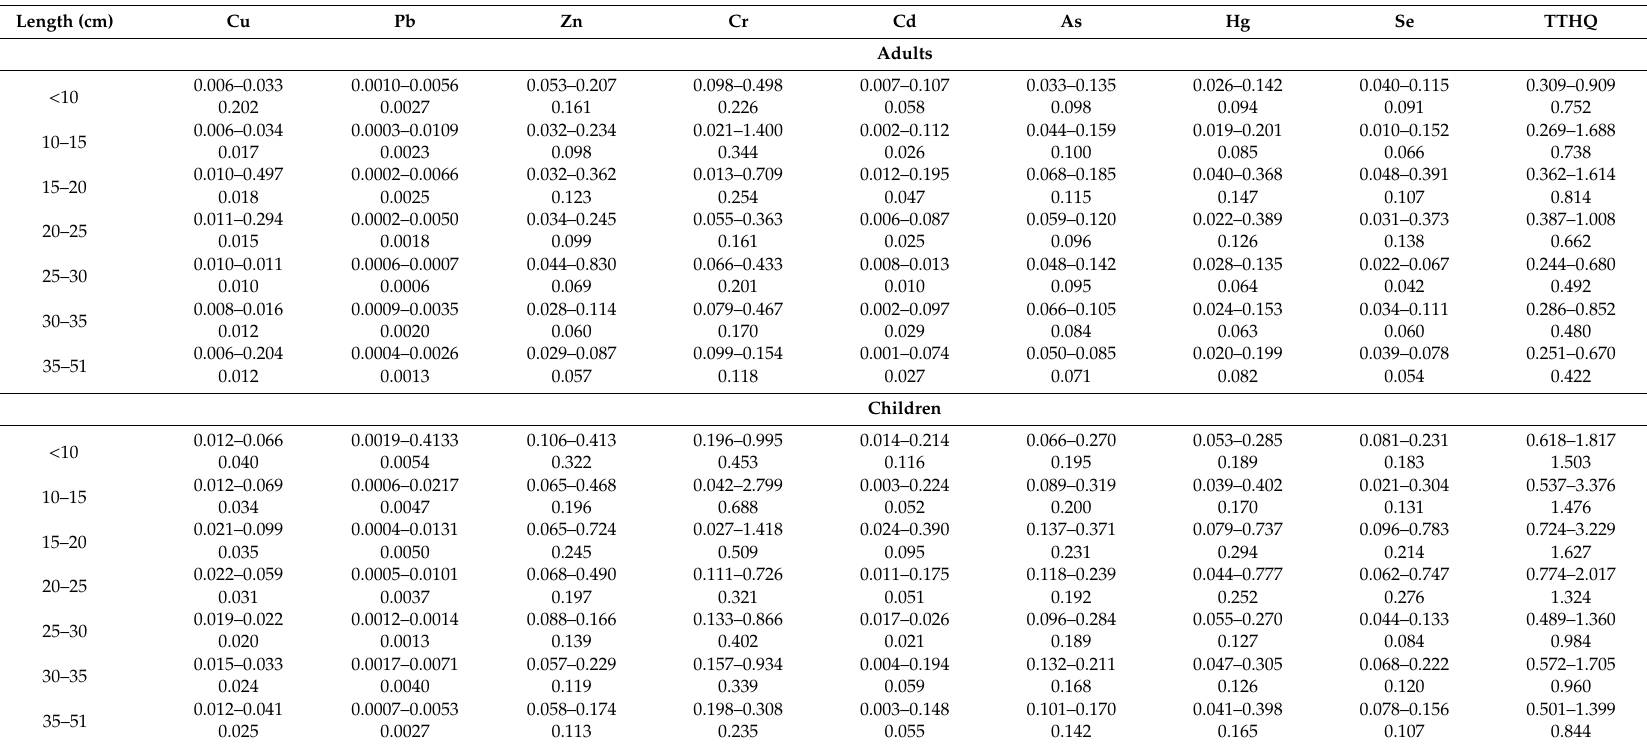
Table 5. Ranges and means of target hazard quotients (THQ) of metals in fish with di ff erent length